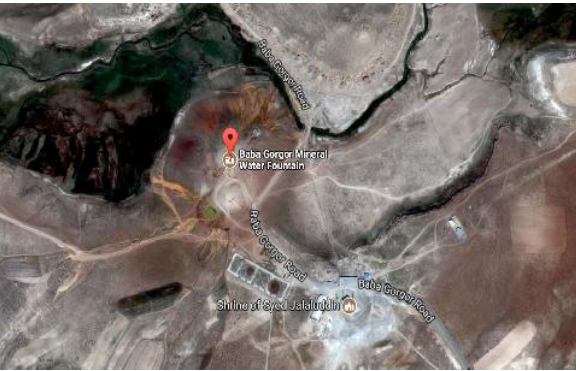
Fig. 1. Location of Kurdistan province on a map of